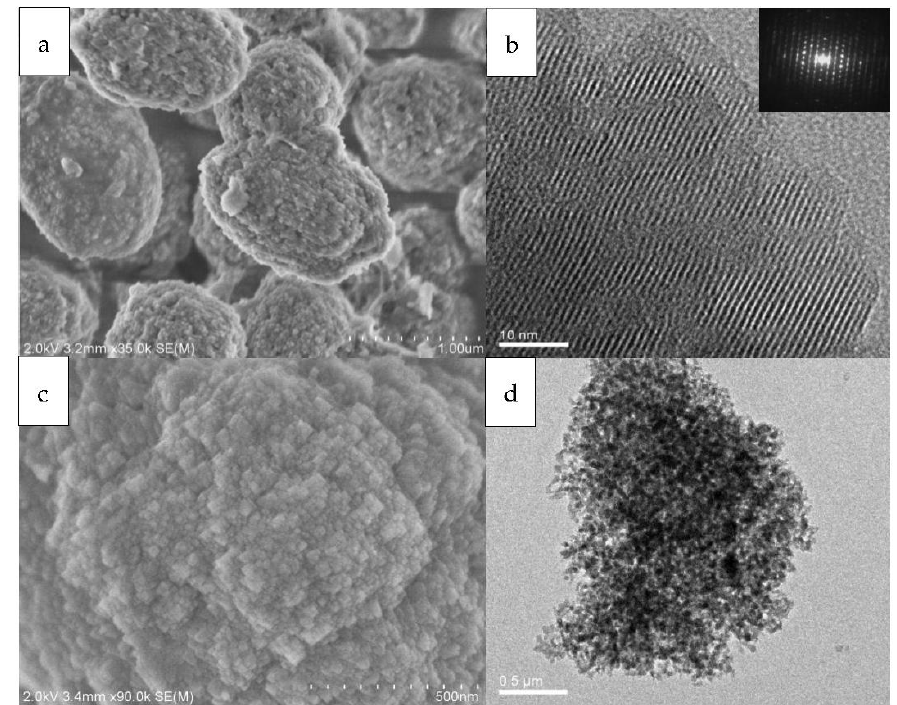
Figure 3. SEM and TEM images of synthesized zeolite Beta samples MZB-5. ( a ) dispersed particles(SEM); ( b ) particle structure (TEM); ( c ) particle surface (SEM); ( d ) particles aggregate (TEM).